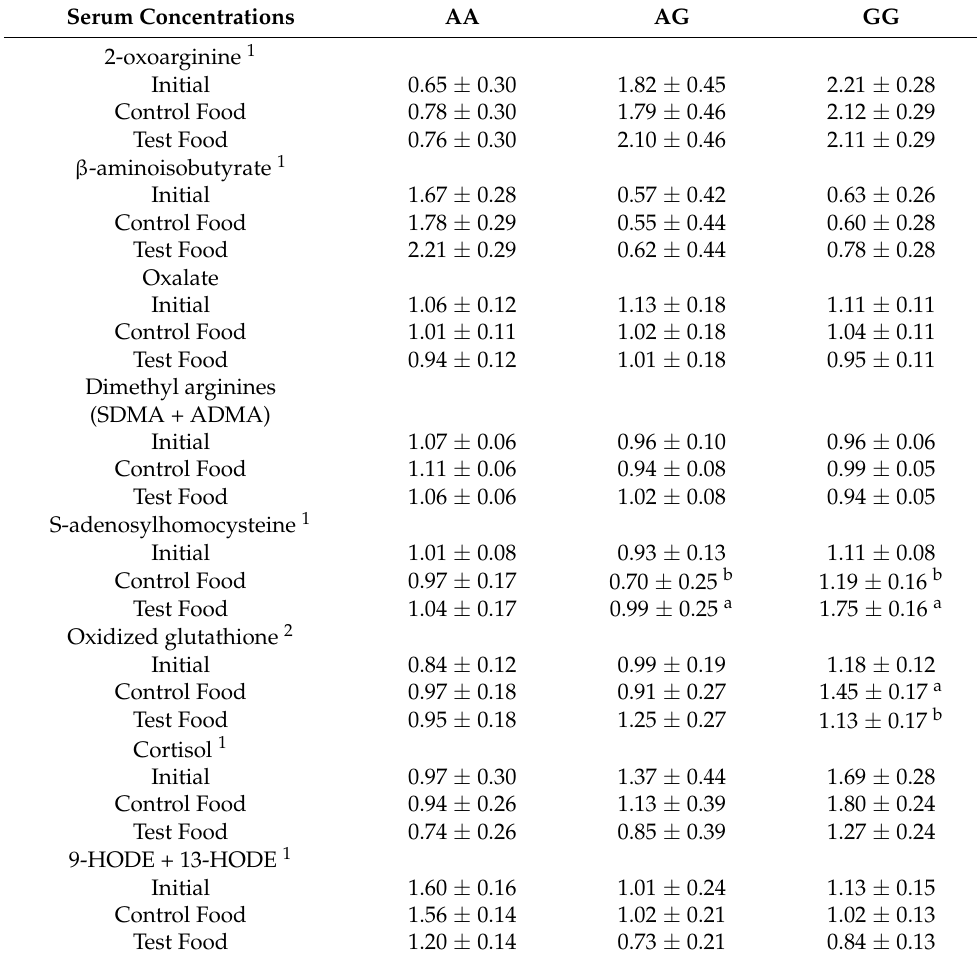
Table 8. Scaled imputed values of the concentrations of selected genotype-specific serum metabolites in cats with different alanine-glyoxylate aminotransferase 2 (AGXT2) single nucleotide polymor- phisms (SNPs) after consuming control or test food for 28